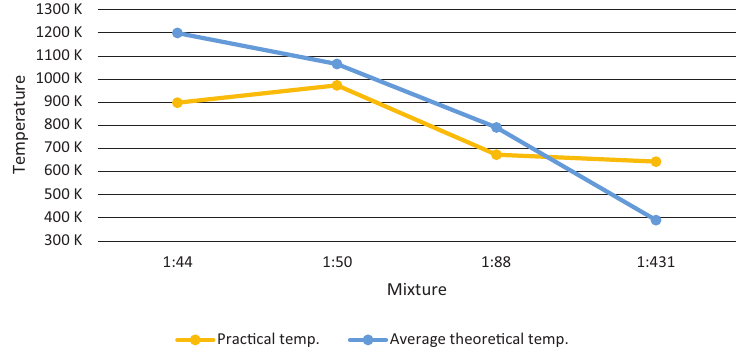
Figure 5. Comparison of average theoretical and practical temperatures